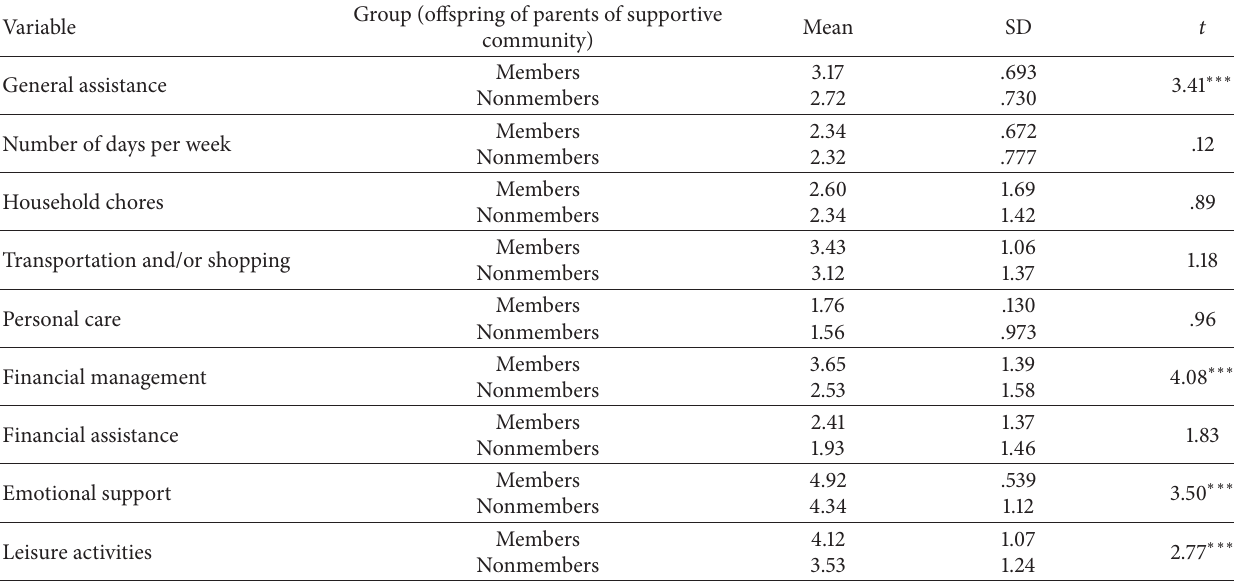
Table 4: Differences in the extent and frequency of care between offspring of supportive community members ( 𝑁 = 55 ) and nonmembers ( 𝑁 = 64